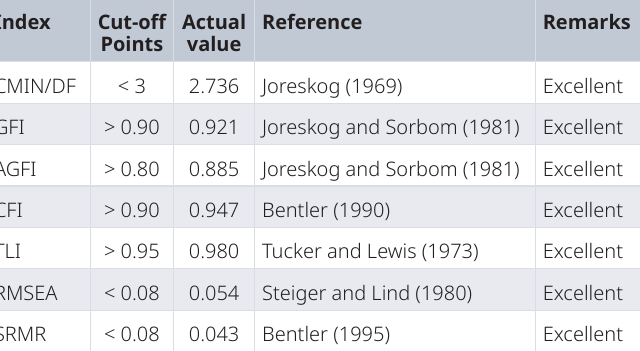
Table 4. Goodness-of-fit indices.